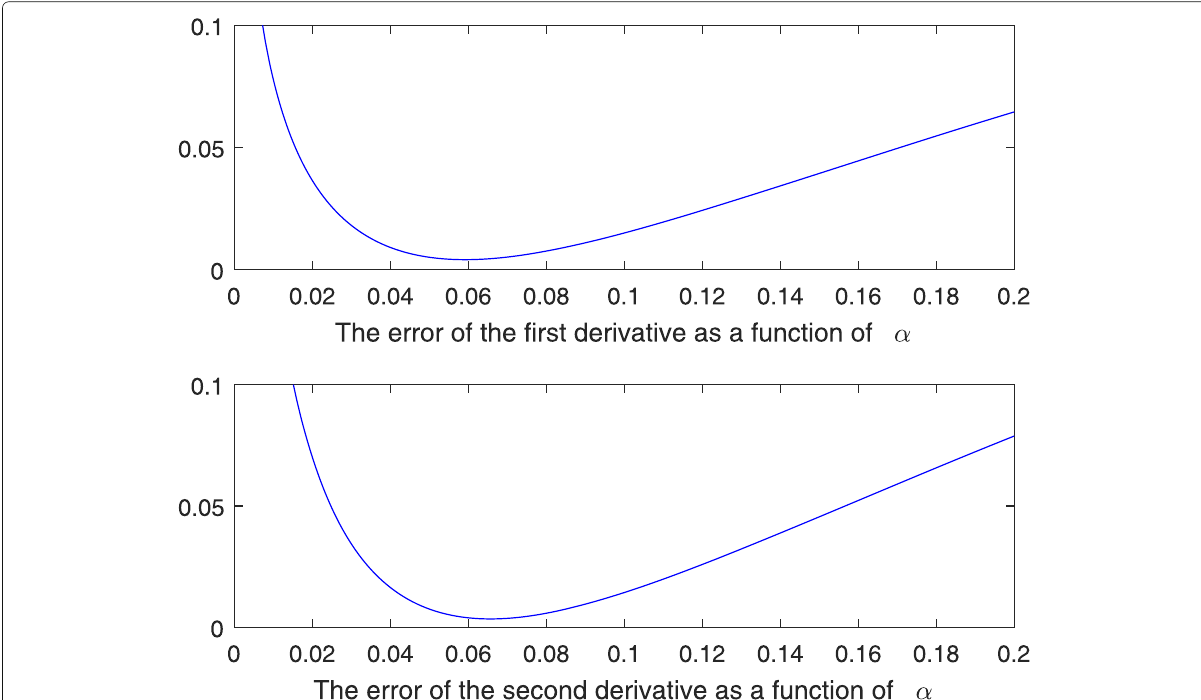
Fig. 10 The results the Square error as a function of α in Example